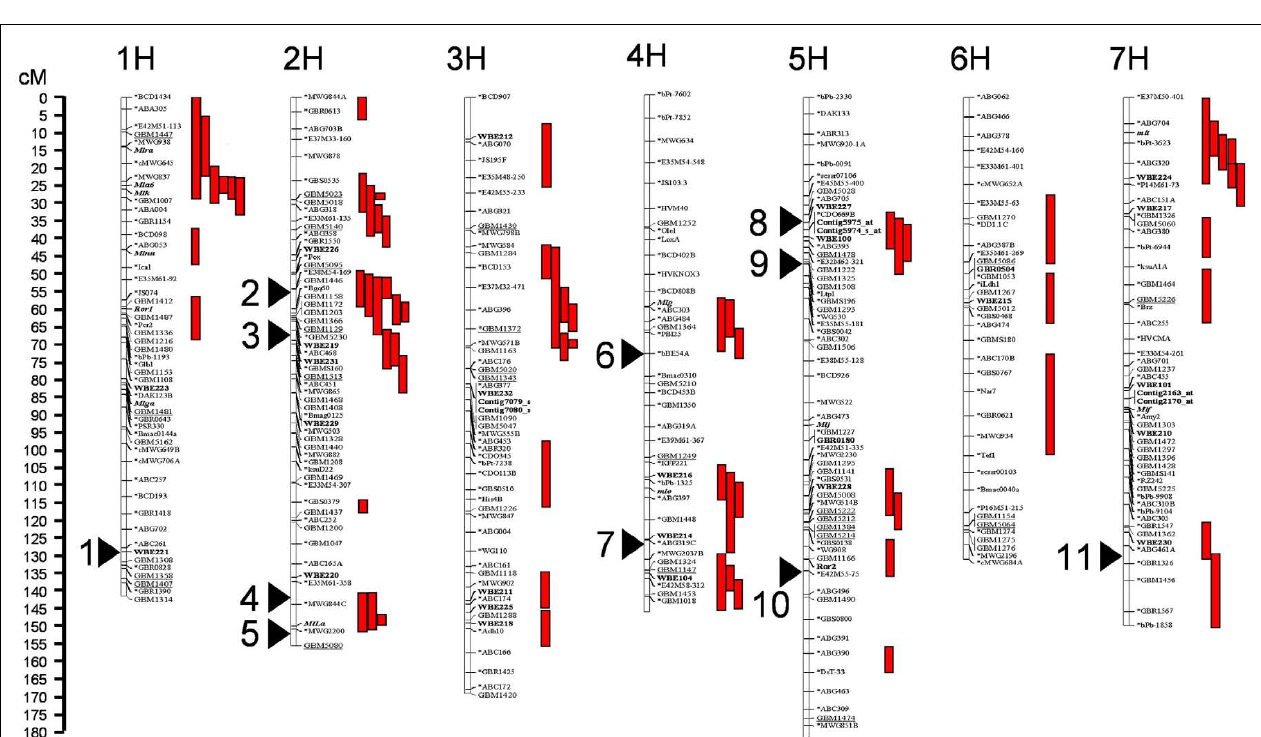
span the distance between QTL flanking markers or indicate peak marker positions ± 5cM. QTL longer than 30cM were excluded from the analysis. Numbers 1–11 indicate AM_IPK_PM01–11 (see also Figure 5